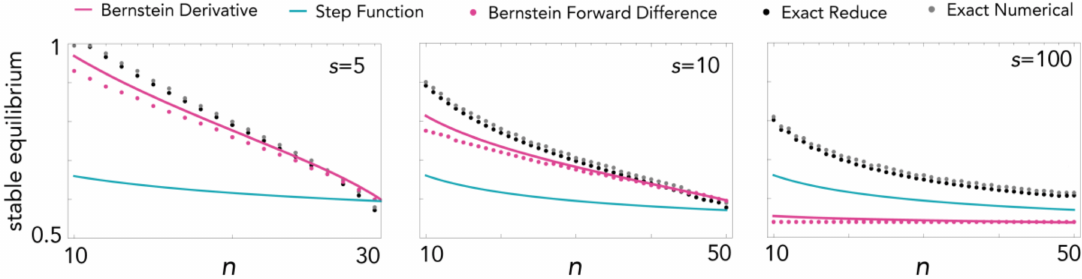
Figure 7. Comparison between the values of the stable equilibria (as a function of n ) calculated using different methods, with c = 0.04, h = 0.5 and different values of s